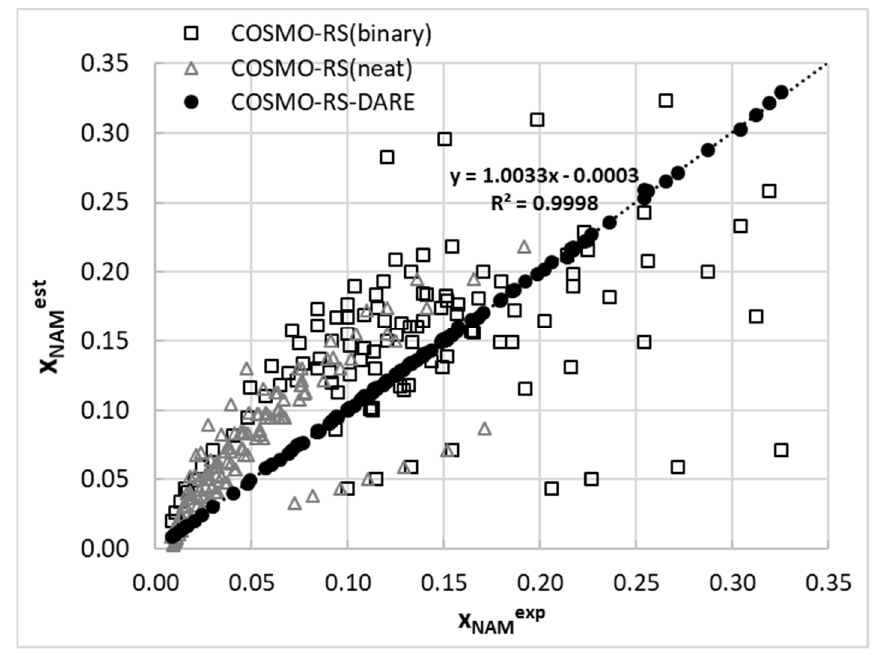
Figure 8. Predicted solubility of nicotinamide confronted with experimental data.